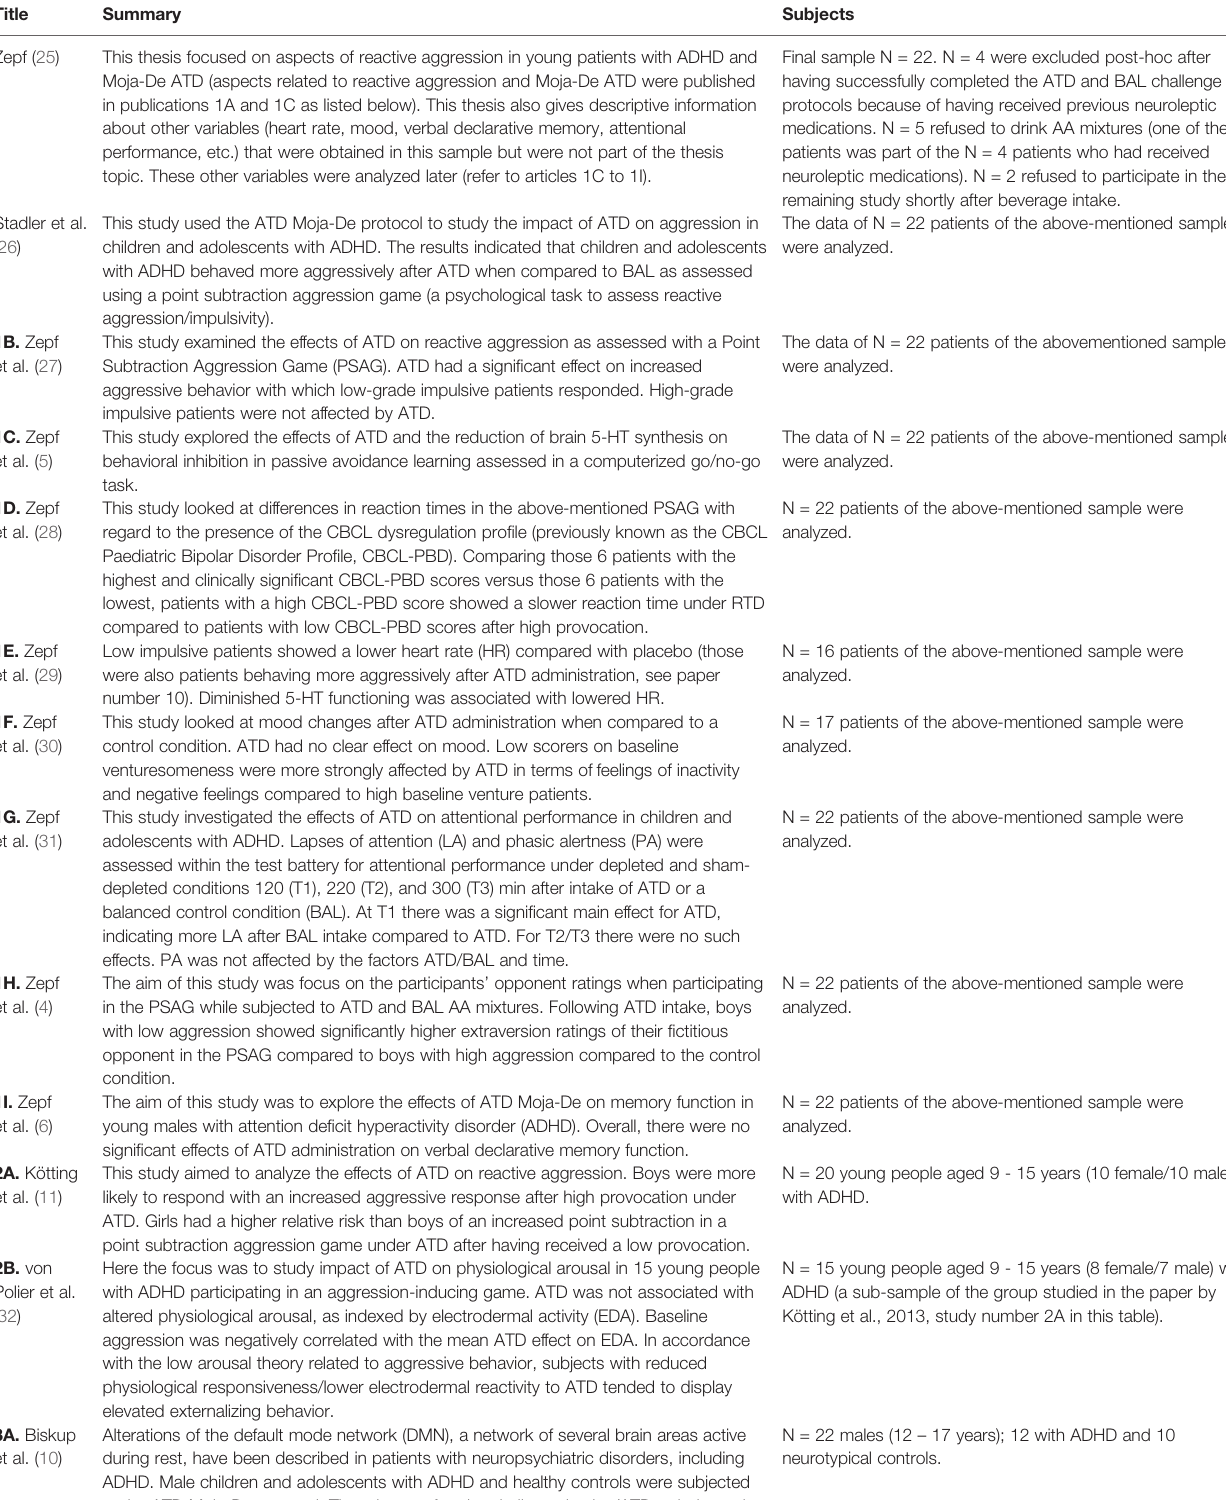
TABLE 2 | Summary of studies employing the ATD Moja-De Protocol in healthy and clinical populations (young people and adults). Summary